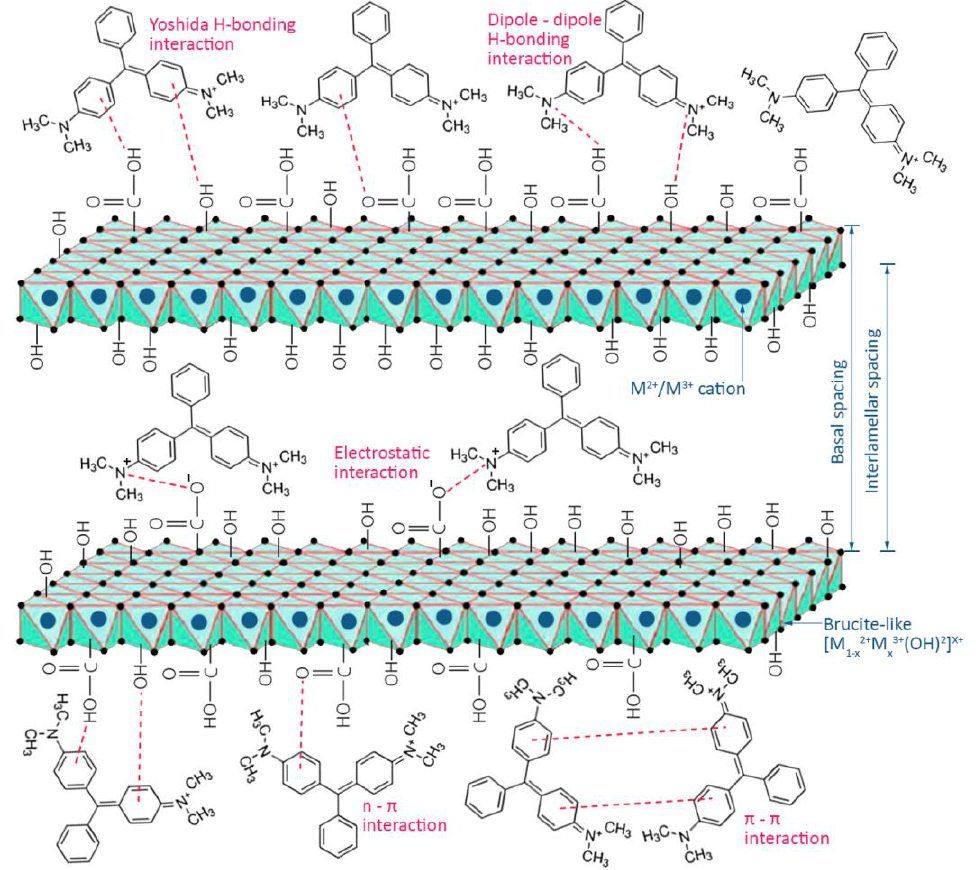
Figure 6. Schematic diagram of possible interactions in LDH with dye molecules. Reprinted from ref. [90] with permission.